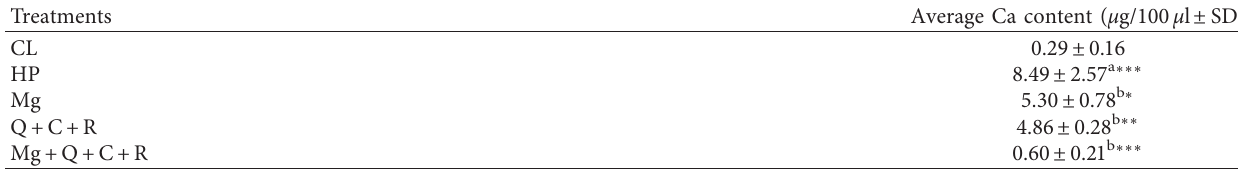
Table 1: Effect of Mg, Q+C+R, and Mg+Q+C +R in rVSMCs cultured in the HP